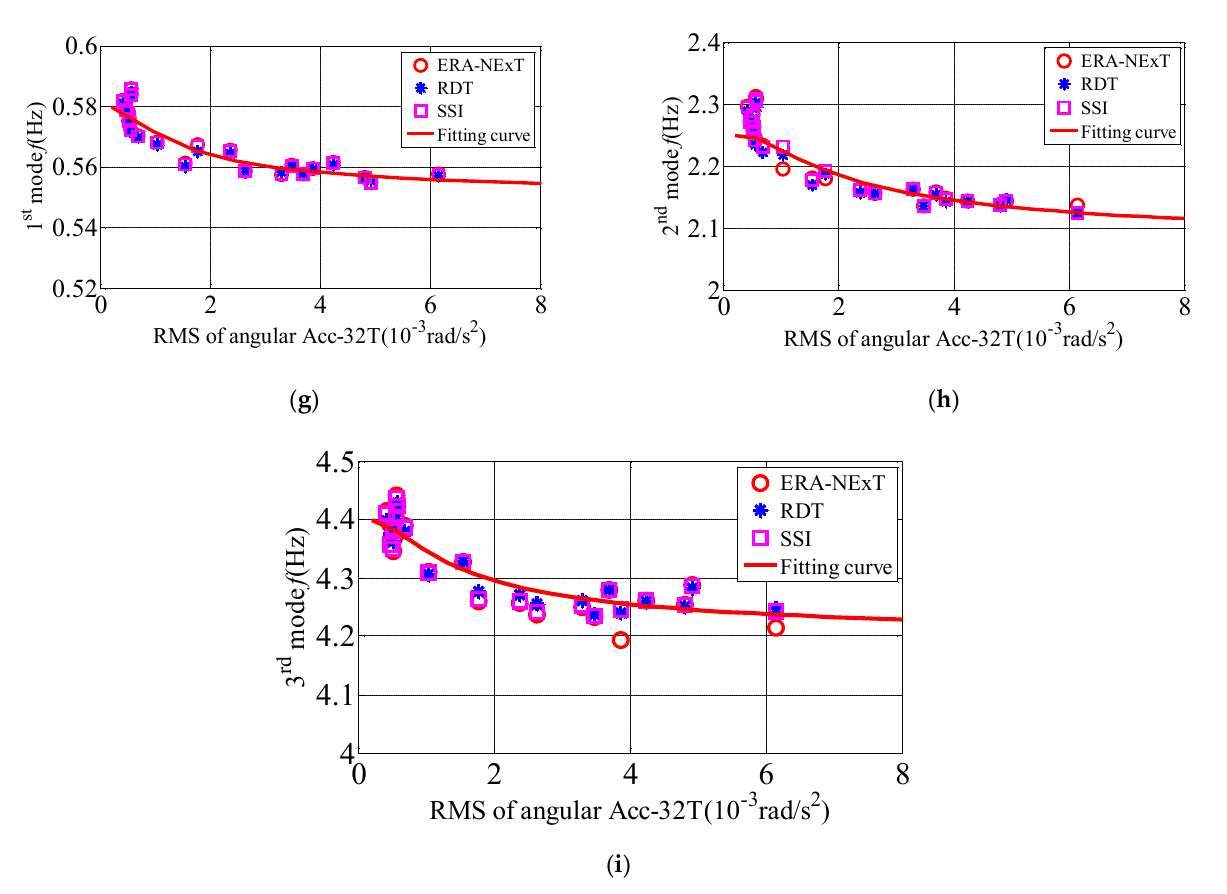
Figure 16. The relationship between translational and torsional modal frequency and RMS of Acc atop the building. ( a ) 1st modal frequency along x -axis; ( b ) 2nd modal frequency along x -axis; ( c ) 3rd modal frequency along x -axis; ( d ) 1st modal frequency along y -axis; ( e ) 2nd modal frequency along y -axis; ( f ) 3rd modal frequency along y -axis; ( g ) 1st modal frequency along torsional direction; ( h ) 2nd modal frequency along torsional direction; ( i ) 3rd modal frequency along torsional direction.